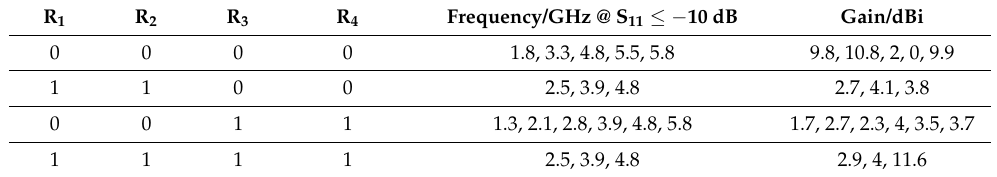
Table 1. Comparison between the switching scenarios operation in terms of antenna performance. 187